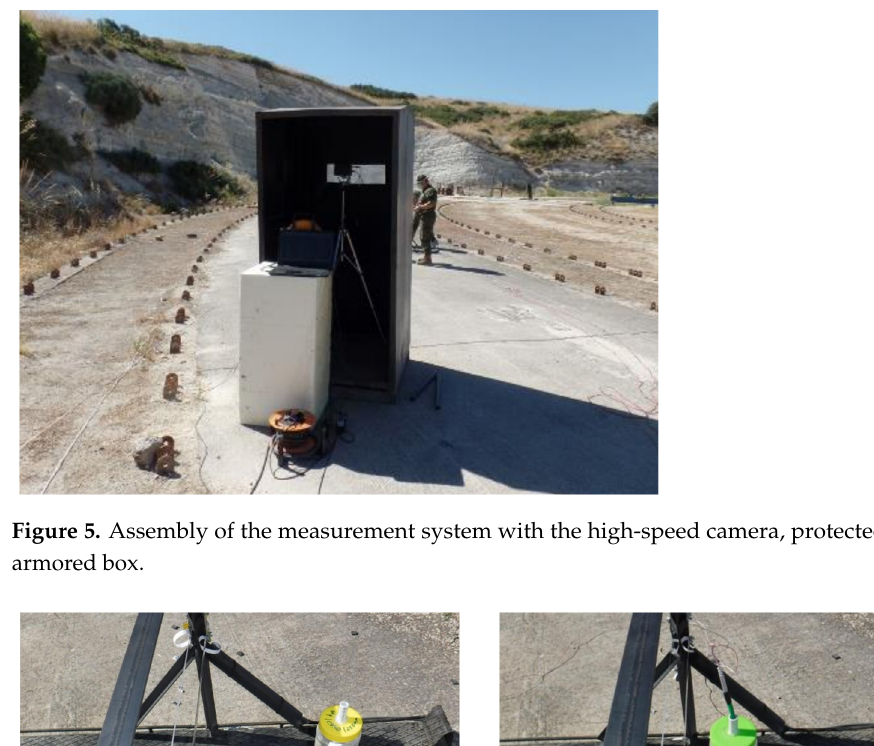
Figure 5. Assembly of the measurement system with the high-speed camera, protected behind an armored box.